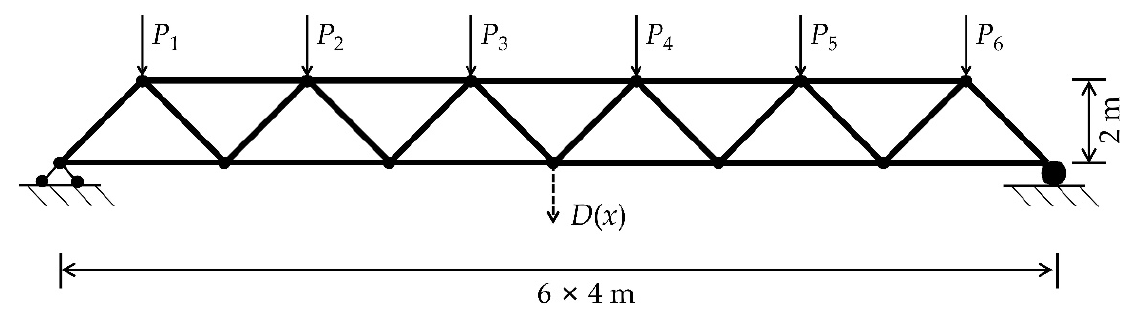
Table 6. Result comparison using different methods for Example 3.